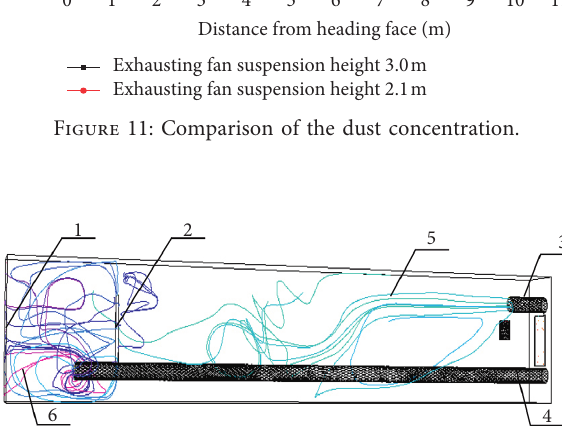
Figure 12: Schematic diagram of dust removal effect of ACDRD. (1) Heading face; (2) air curtain; (3) forcing ventilation; (4) exhaust ventilation; (5) fresh air; (6) exhaust